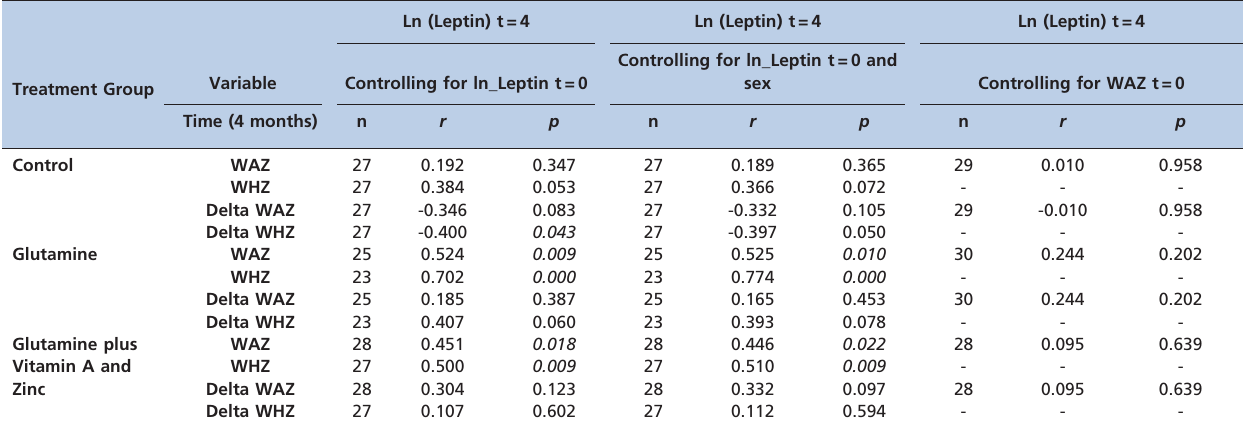
n =number of children; r =Pearson correlation coefficient; p =statistical significance